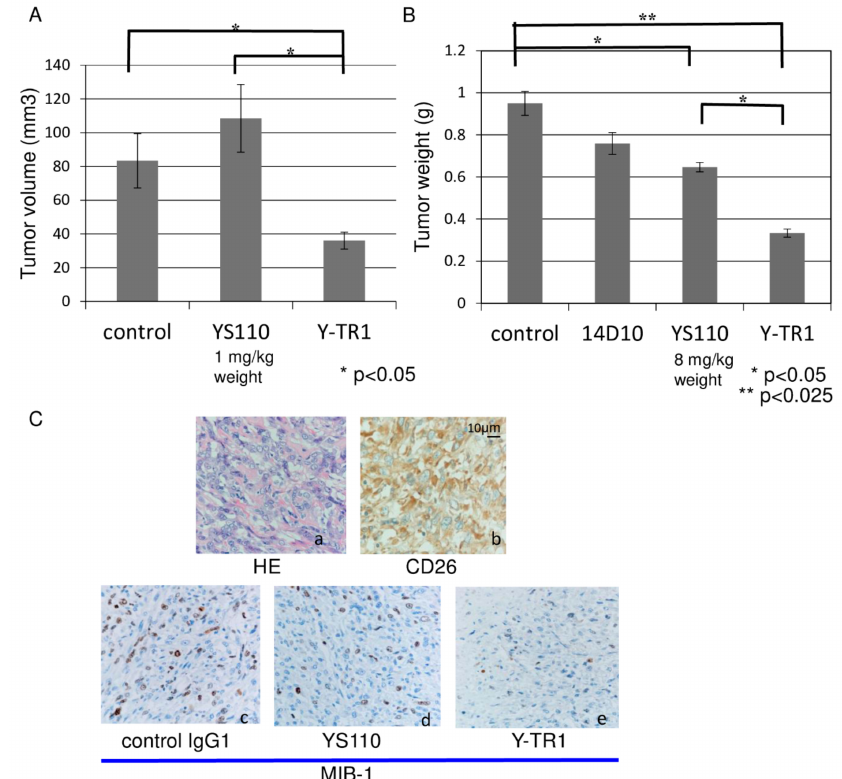
Figure 7. In vivo anti-tumor effect of Y-TR1 in the NOD / SCID mouse xenograft model using the CD26 positive MM cell line JMN. ( A ) Y-TR1 was administered intraperitoneally 4 mg / kg / dose, three times per week, for a total of nine doses from day zero of subcutaneous inoculation of 1 × 107 JMN cells. The average estimated tumor volume on day 55 was compared among three groups (control, YS110, Y-TR1, n = 10) with Fisher’s protected least protected difference multiple comparison test. The mean tumor volume of the Y-TR1 group was significantly lower (* p < 0.05) than that of the control or YS110 group. The mean tumor volume of the YS110 group was not significantly altered compared with the control. An experiment out of two with similar results is shown; ( B ) Y-TR1 was administered intraperitoneally 8 mg / kg / dose, three times per week, for a total of nine doses. The average estimated tumor weight on day 42 was compared among three groups (control, 14D10, YS110, Y-TR1, n = 10) with Fisher’s protected least protected difference multiple comparison test. The mean tumor weight of the YS110 or Y-TR1 groups was significantly lower (* p < 0.05 or ** p < 0.025, respectively) than that of the control group. The mean tumor weight of the Y-TR1 group was significantly lower (* p < 0.05) than that of the YS110 group. An experiment out of two with similar results is shown; ( C ) histological analysis of xenograft tumors of JMN cells. JMN-derived tumors show histopathology of sarcomatoid mesothelioma. ( × 20). a: Hematoxylin and eosin staining. b: Immunohistochemical staining with anti-human CD26 antibody revealed CD26 expression in tumor cells. c–e: MIB-1 (Ki67) staining showed a decreased number of MIB-1-positive cells in Y-TR1-treated tumors compared to IgG1- or YS110-treated tumors. Scale bar: 10 µ